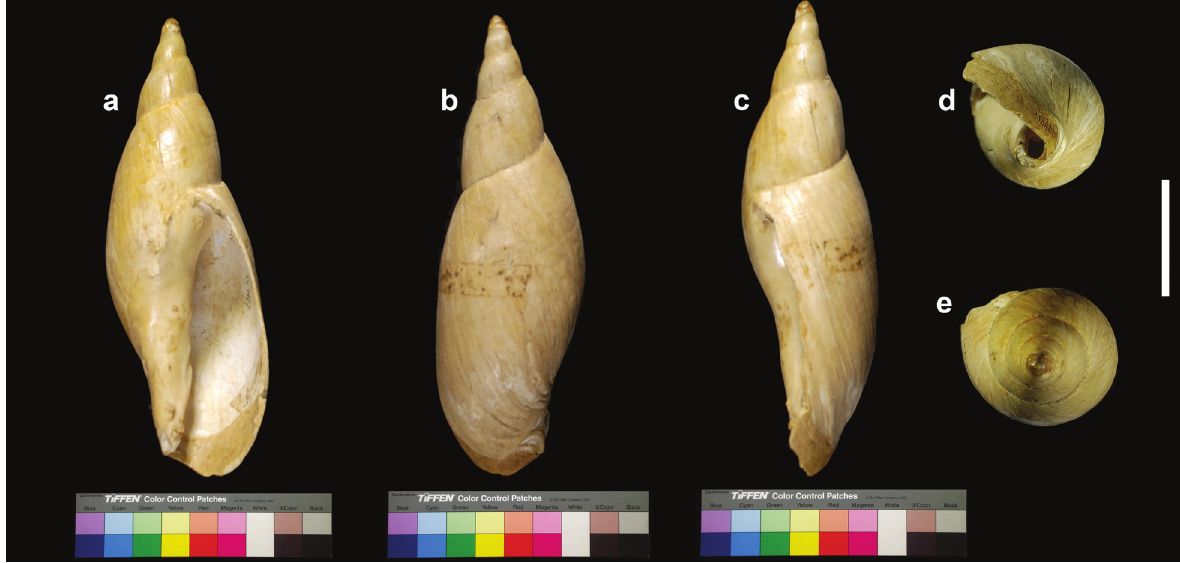
Figure 9. Voluta ancilla elongata , holotype figured by Lahille. a Apertural view b Dorsal view c Lateral view d Umbilical view e Apical view. Scale bar: 5